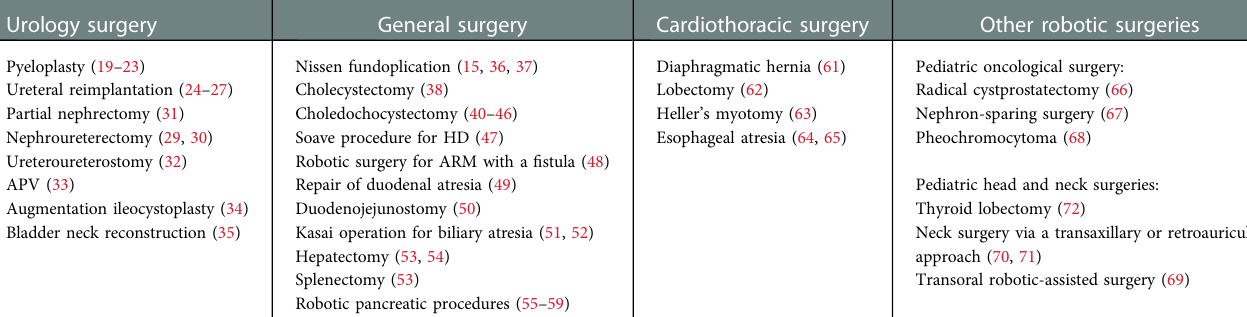
TABLE 1 Summary of the reported pediatric robotic surgical procedures in this